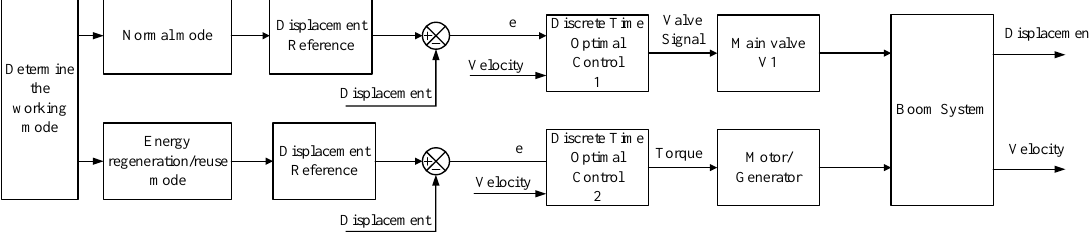
Figure 7. Displacement tracking control based on discrete time-optimal control.